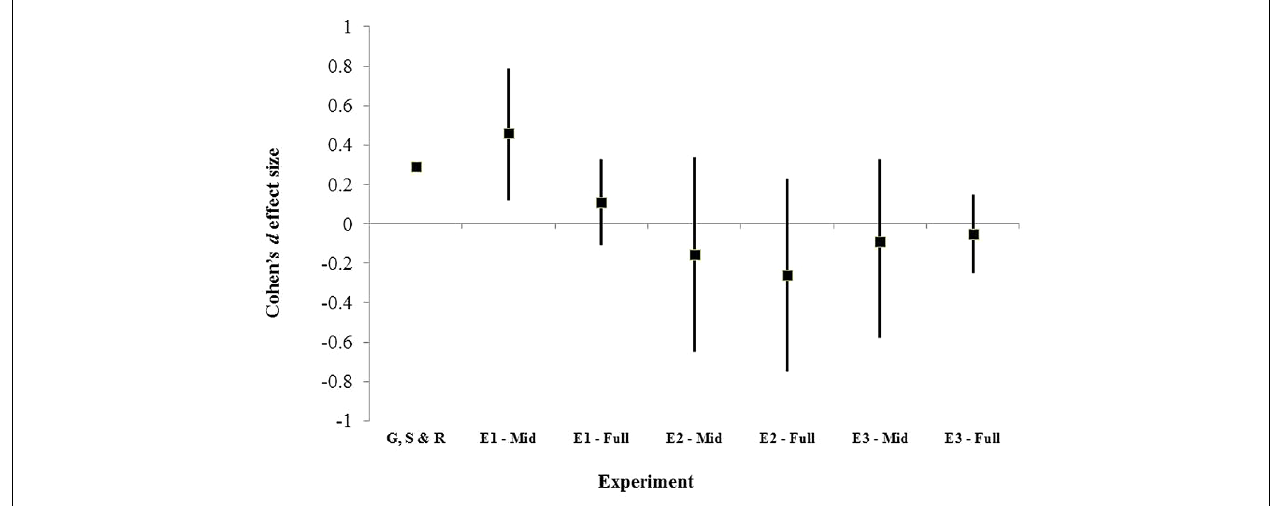
FIGURE 4 |The mean effect sizes (Cohen’s d) and 95% confidence intervals for Mid-list and Full-list correct recall under DVN for Experiments 1 to 3 (E1–E3). Glenberg etal.’s (1998; G,S and R) mean effect size is included for comparison, but no confidence intervals are available.